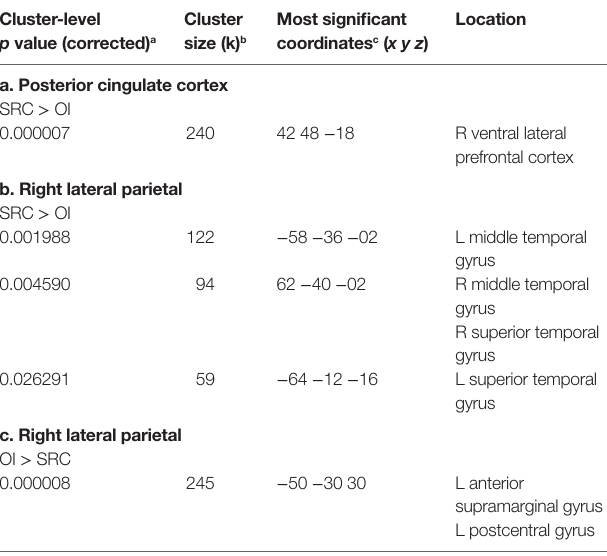
Table 3 | between groups T -tests showing significant group differences in functional connectivity between the clusters shown and seeds in the (a) posterior cingulate cortex (src > Oi); (b) right lateral parietal (src > Oi); and (c) right lateral parietal (Oi >